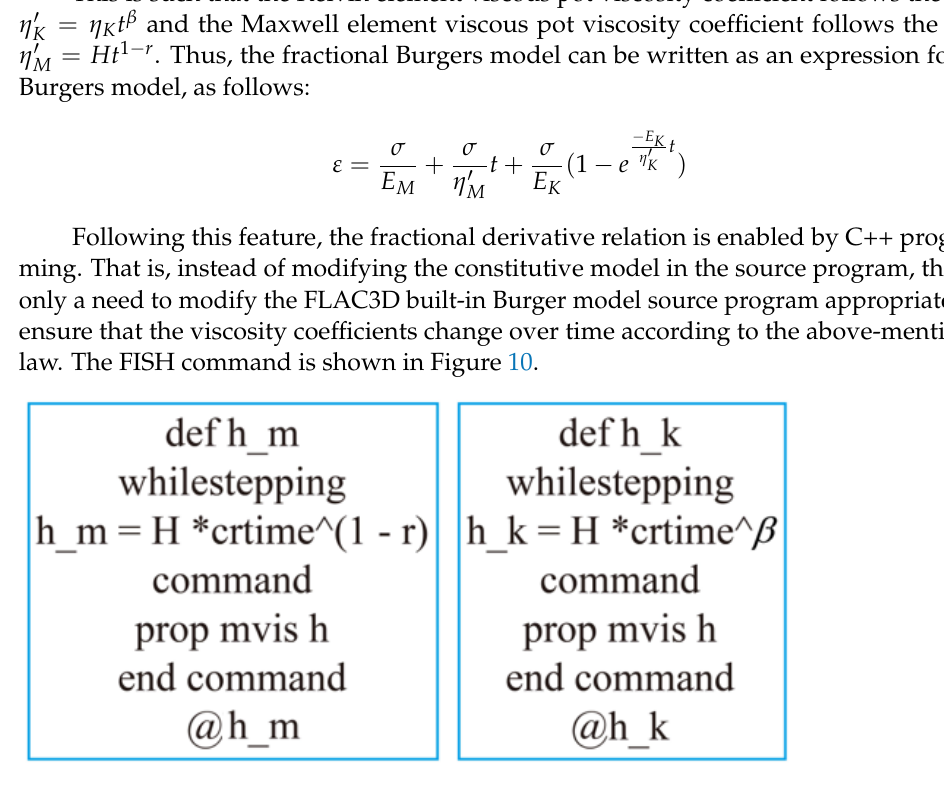
Figure 10. FISH language for implementing fractional models in FLAC3D.